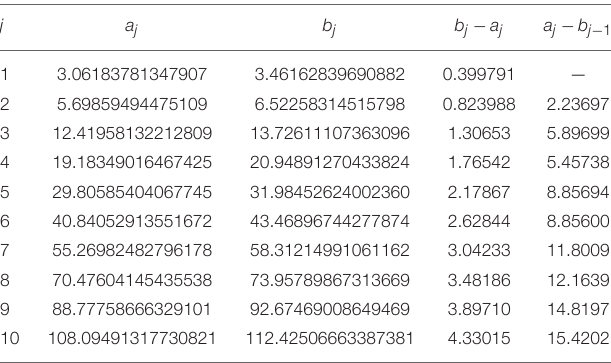
FIGURE 3 | Plot of the approximate function TABLE 3 | Some spectral bands